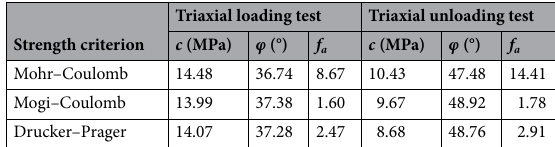
Table 3. c and φ values of argillaceous sandstone under different criteria.